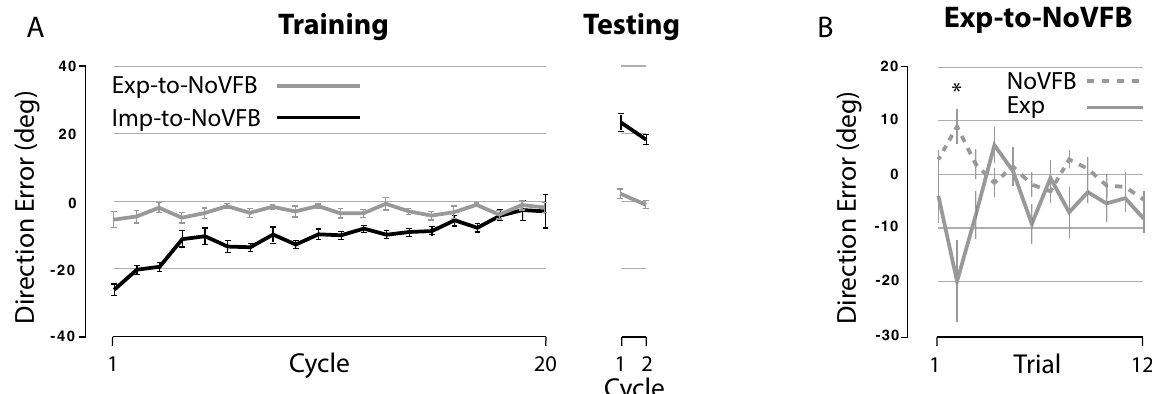
Fig 8. Changes in performance in Exp-to-NoVFB and Imp-to-NoVFB groups. (A) Each data point represents mean DE across six consecutive trials (cycle). Performance changes across cycles in Exp-to-NoVFB and Imp-to-NoVFB groups are shown for training (left) and testing (right) sessions separately. (B) Each data point represents DE for a given trial. Performance changes across trials in Exp-to-NoVFB group are shown for training (Exp) and testing (NoVFB) sessions separately. � indicates significant difference, p < .05.